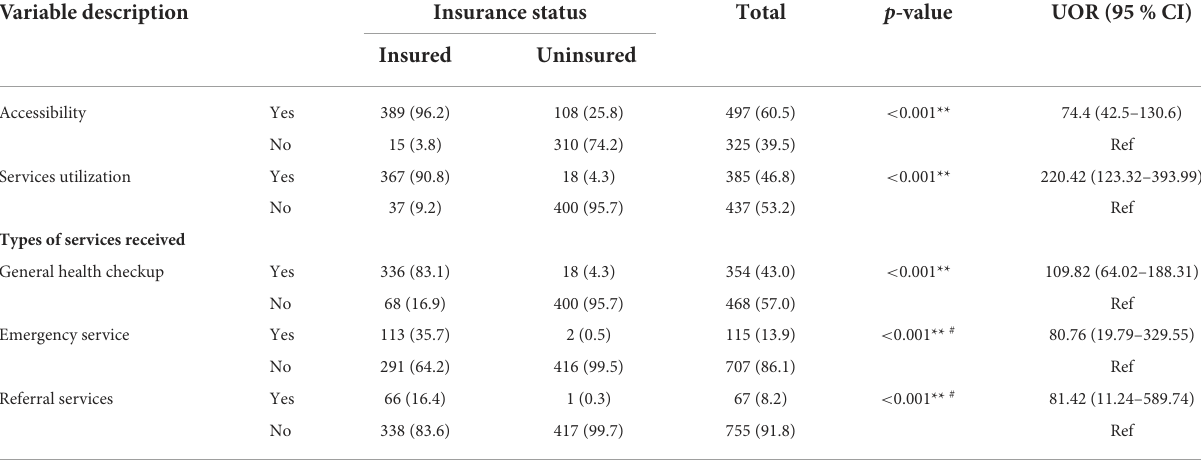
TABLE 4 Associated demand-side factors of insurance providing health facilities.